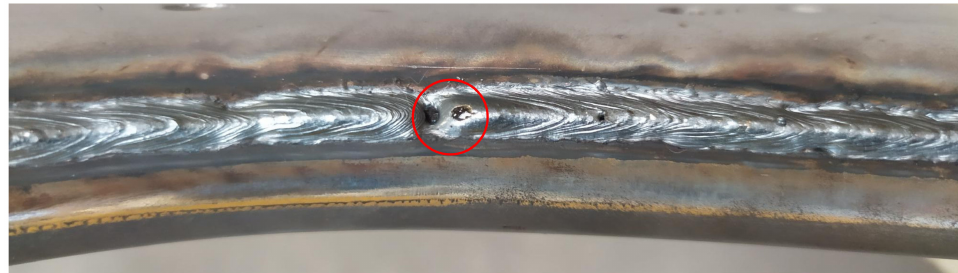
Figure 10. Defects when using incorrect welding parameters ( I = 210 A, v = 80 cm · min − 1